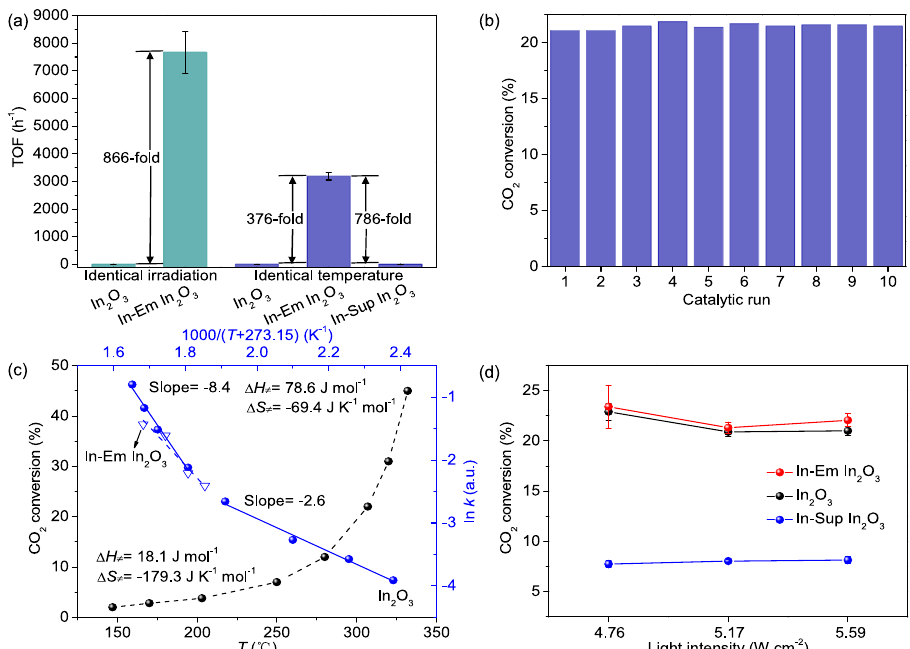
Fig. 3 CO 2 reduction performances over 1 h. a TOF activities over In 2 O 3 , In-Em In 2 O 3 and In-Sup In 2 O 3 . b Cycling experiment over In-Em In 2 O 3 for 10 runs. c Reaction temperature dependence of CO 2 conversion, the corresponding curve of ln k ( k : rate constant) vs. 1000/( T + 273.15) and corresponding Δ H ≠ and Δ S ≠ extracted from Eyring plot. d CO 2 conversion over In 2 O 3 , In-Em In 2 O 3 and In-Sup In 2 O 3 under light irradiation. Note that insuf fi cient temperature was compensated via electric heating to 300 °C. (The error bars represent standard